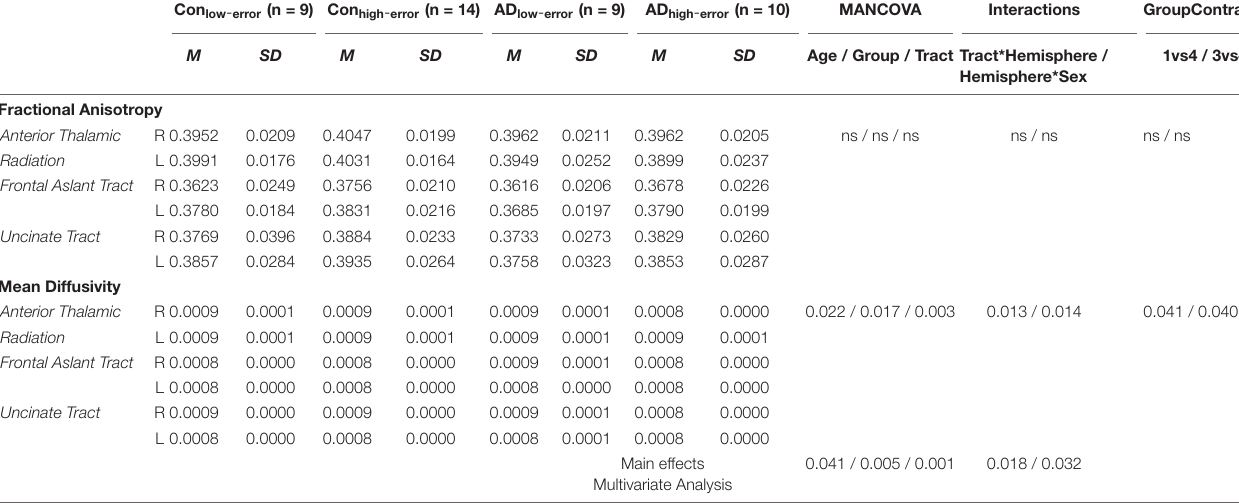
TABLE 3 | Comparisons for the integrity of three frontal tracts between the subgroups of older controls and